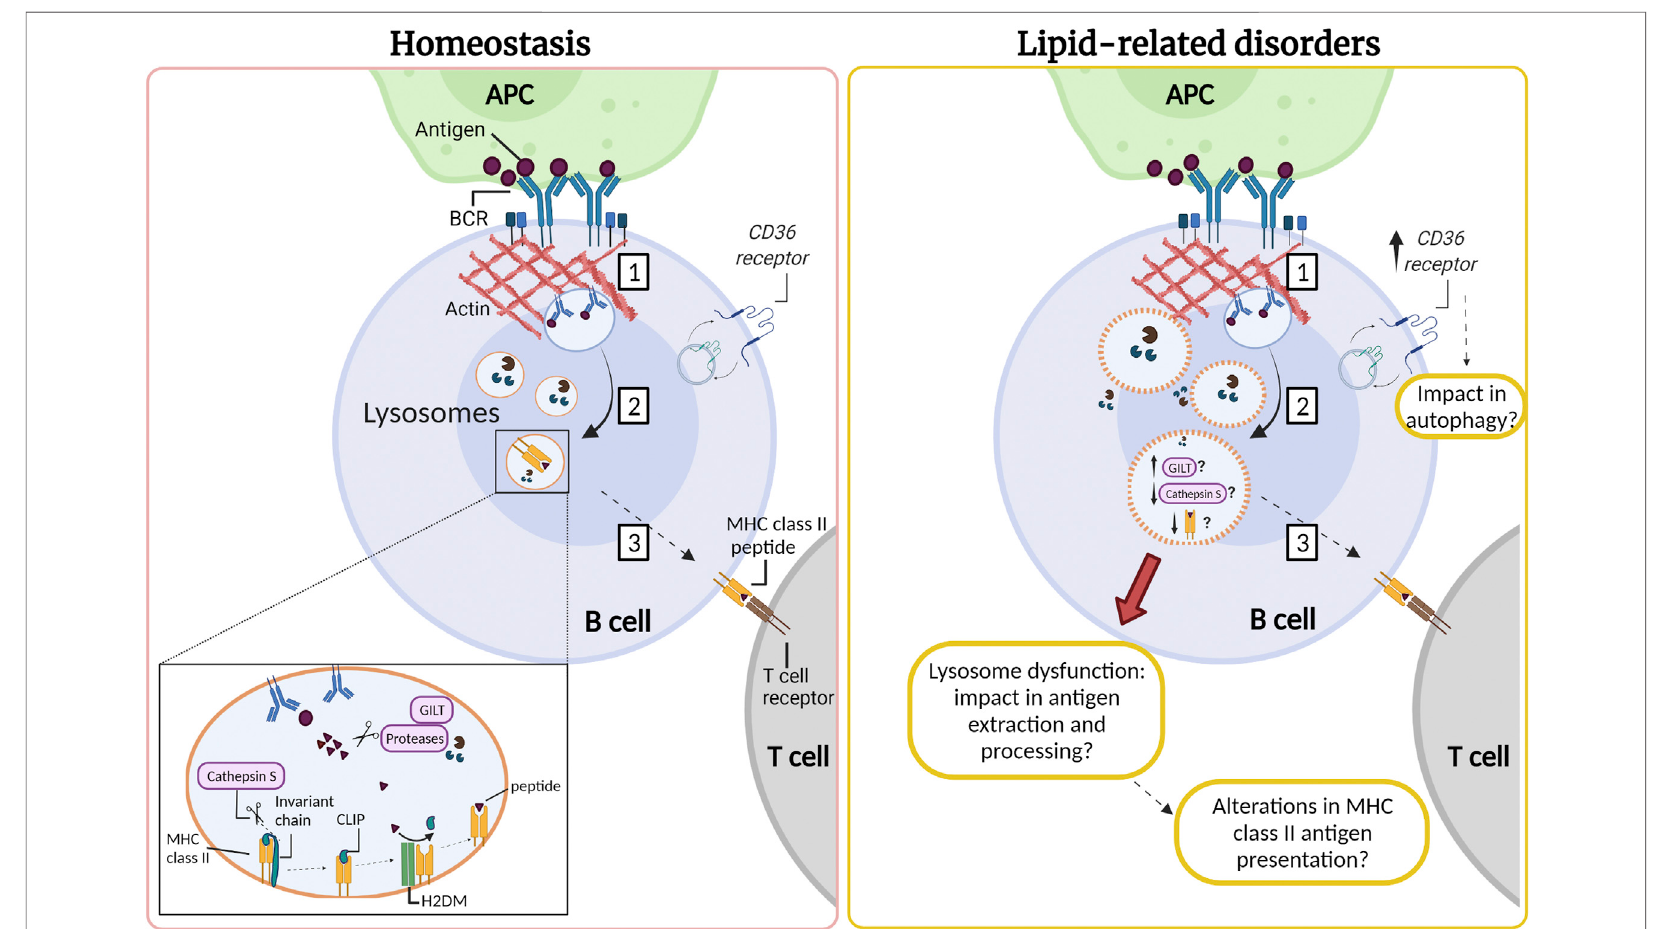
FIGURE 2 | Lysosomes are required for antigen processing in B cells: impact of lipid-related disorders. (1) The interaction of the B cell receptor (BCR) with antigens tethered at the surface of an antigen presenting cell(APC) givesrisetoanimmune synapse. Activation oftheBCRtriggerssignaling cascades which induceextensive remodeling oftheactin cytoskeleton at thesynapticinterface, promoting membrane extensions and ef fi cientBCR-antigeninternalizationintolateendosomalcompartments.(2)BCR-antigenconvergesintolysosomeswhichcontaintheaccessorymolecules,suchasGILT,H2DM,proteasesandMHCclassII.MHCclass II molecules are associated with the invariant chain, which undergoes proteolysis by cathepsin S generating a smaller fragment called CLIP. Subsequently, the H2DM chaperone catalyzes the exit of CLIP and the loadingofantigenicpeptides intotheMHC-II pocket.(3)Next, MHC-IImoleculesaretransportedtothesurfaceoftheBcelltobepresented totheCD4 + Tlymphocyte topromote B-Tcellcooperation.Wespeculatethat Bcellsthatin fi ltrate thein fl amedadiposeand livertissue inlipid-related disorderscould alsopresent lysosomal dysfunctionresulting inlowercathepsinSlevels oractivity. Moreover, Bcells mightexhibitpermeabilization oftheirlysosomemembrane,similarlytoobservationsinothercelltypesinlipid-relateddisorders.WesuggestthatinobesitytherecouldalsobeanincreaseintheexpressionofCD36,whichmaybeenhanceduponBcell activation. Thismightimpact inautophagy, enhancing thecanonicalpathway and diminishing noncanonical autophagy.Such defectscould impact thecapacityofBcellstoextract andprocess antigens,which relieson lysosome integrity. However, these functions remain to be evaluated and the question that arises is how are lysosomes in B cells affected by an excess of nutrients in obesity and